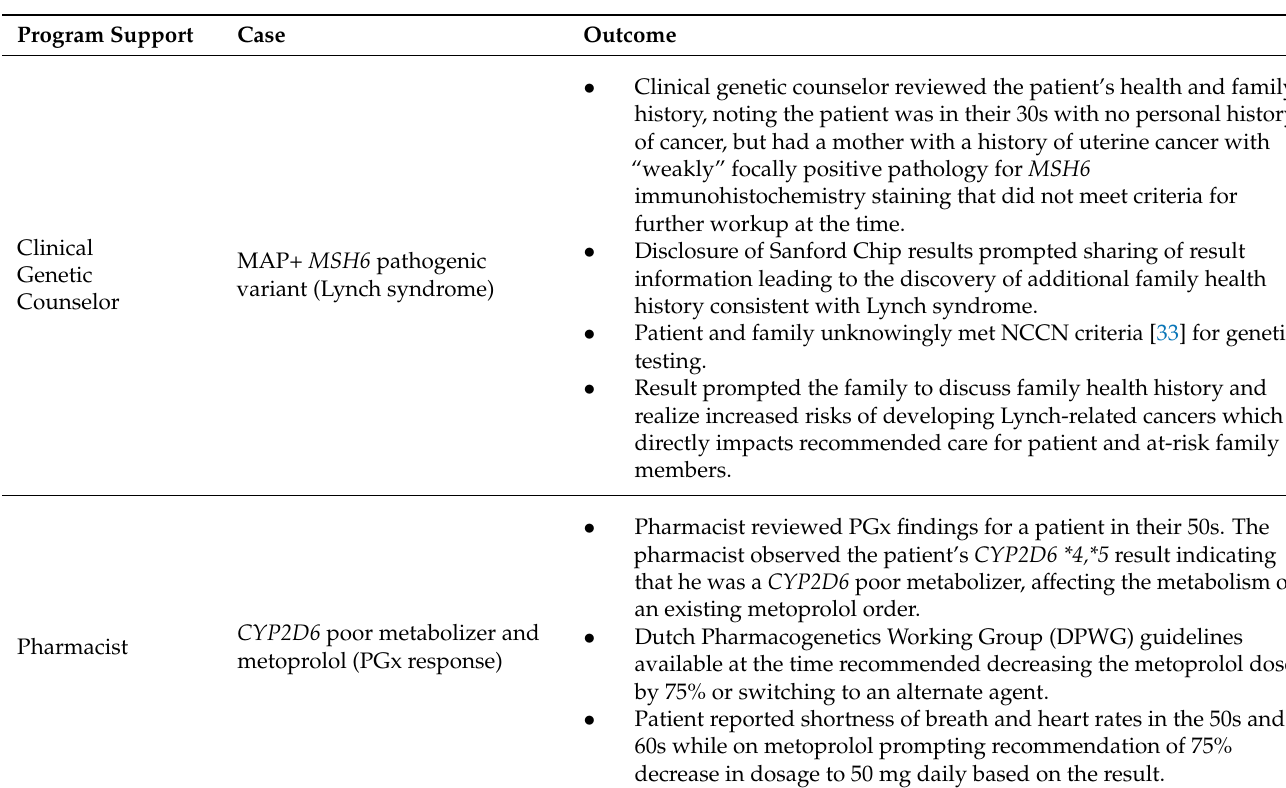
Table 3. Clinical vignettes for patients who received the genetic screen from the precision medicine